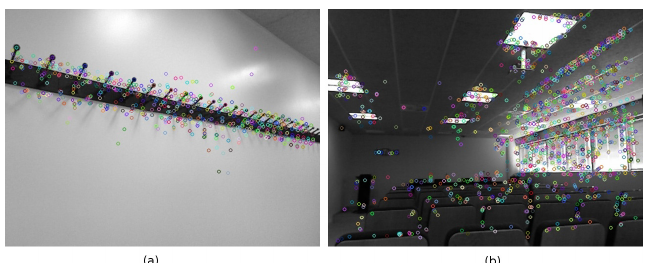
Figure 1. ( a ) Concentrated key points in an image with few objects. ( b ) High scattering of key points in an extensive view.